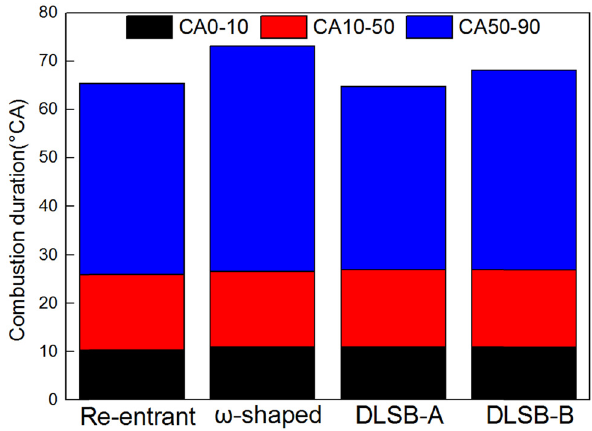
Figure 9: Combustion durations for di ff erent piston bowls.